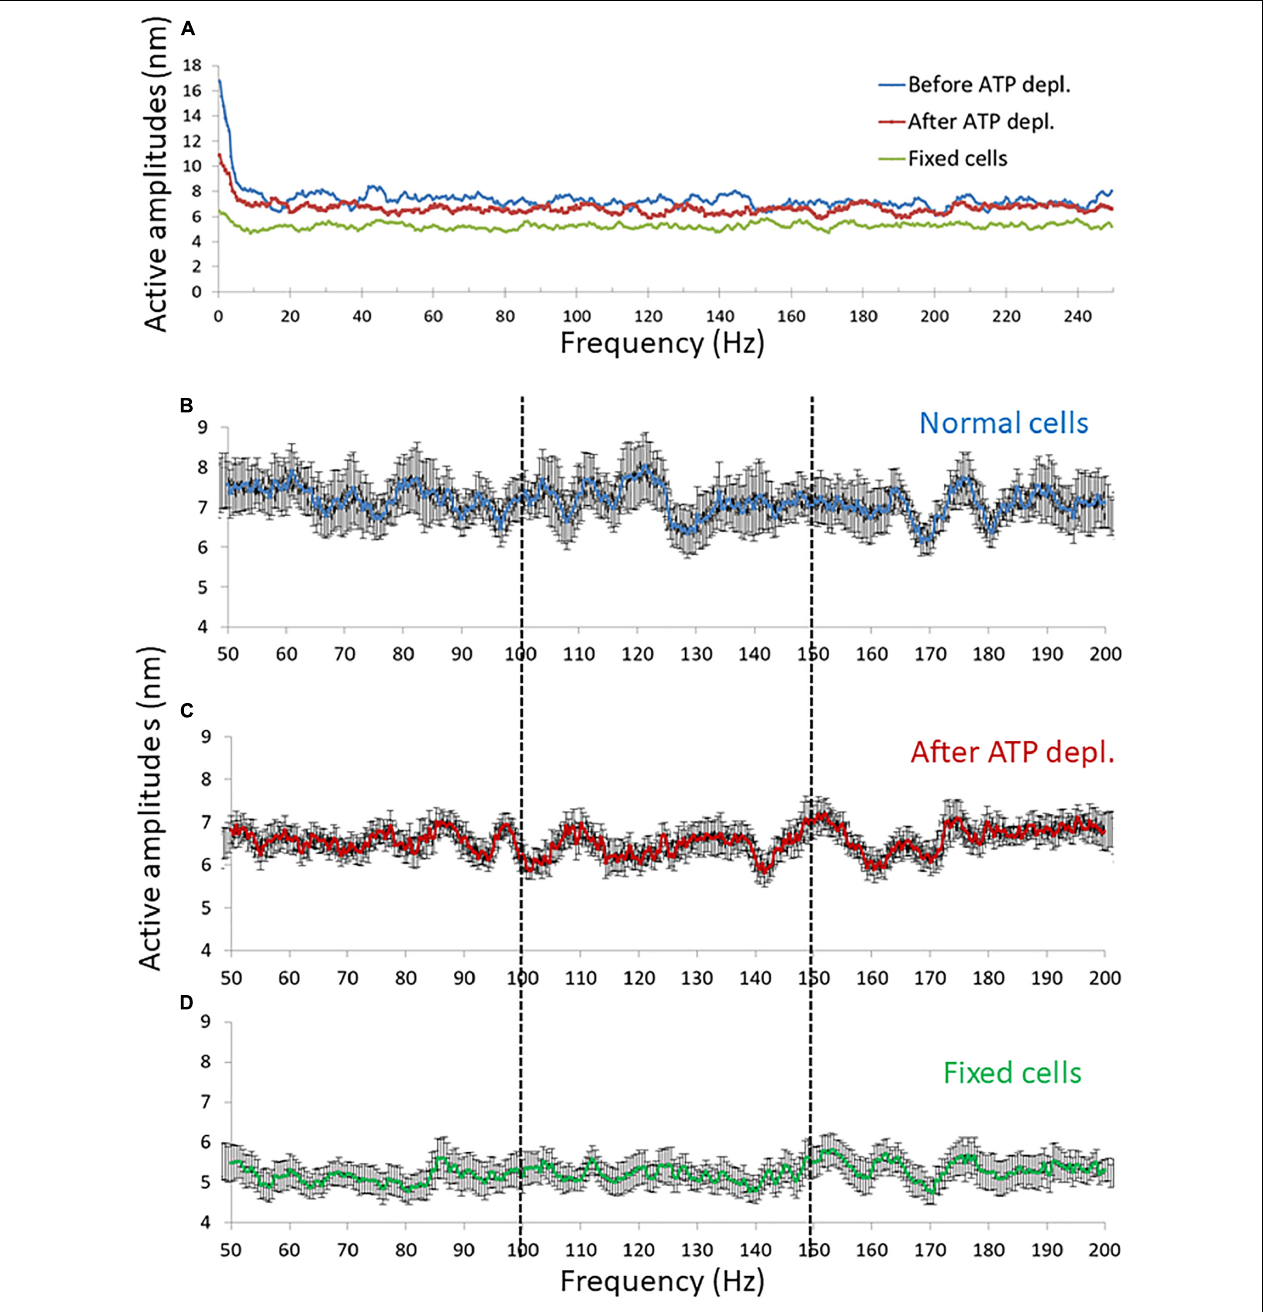
FIGURE 8 | Amplitude spectral density (ASD) results in high frequencies ( > 50 Hz). (A) Average ASD results in normal non-treated cells ( N = 14), adenosine triphosphate (ATP) depleted cells ( N = 14) and dead fixated cells ( N = 20). (B–D) Average ASD results in the frequencies range between 50 and 200 Hz in normal non-treated cells (B) , ATP depleted cells (C) , and fixated dead cells (D) . Error bars in panels (B–D) are